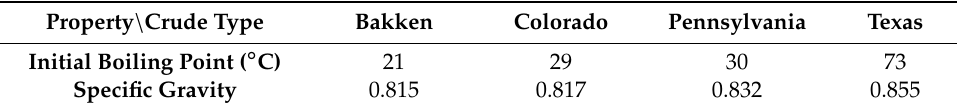
Table 1. Typical properties of crude oils being tested.